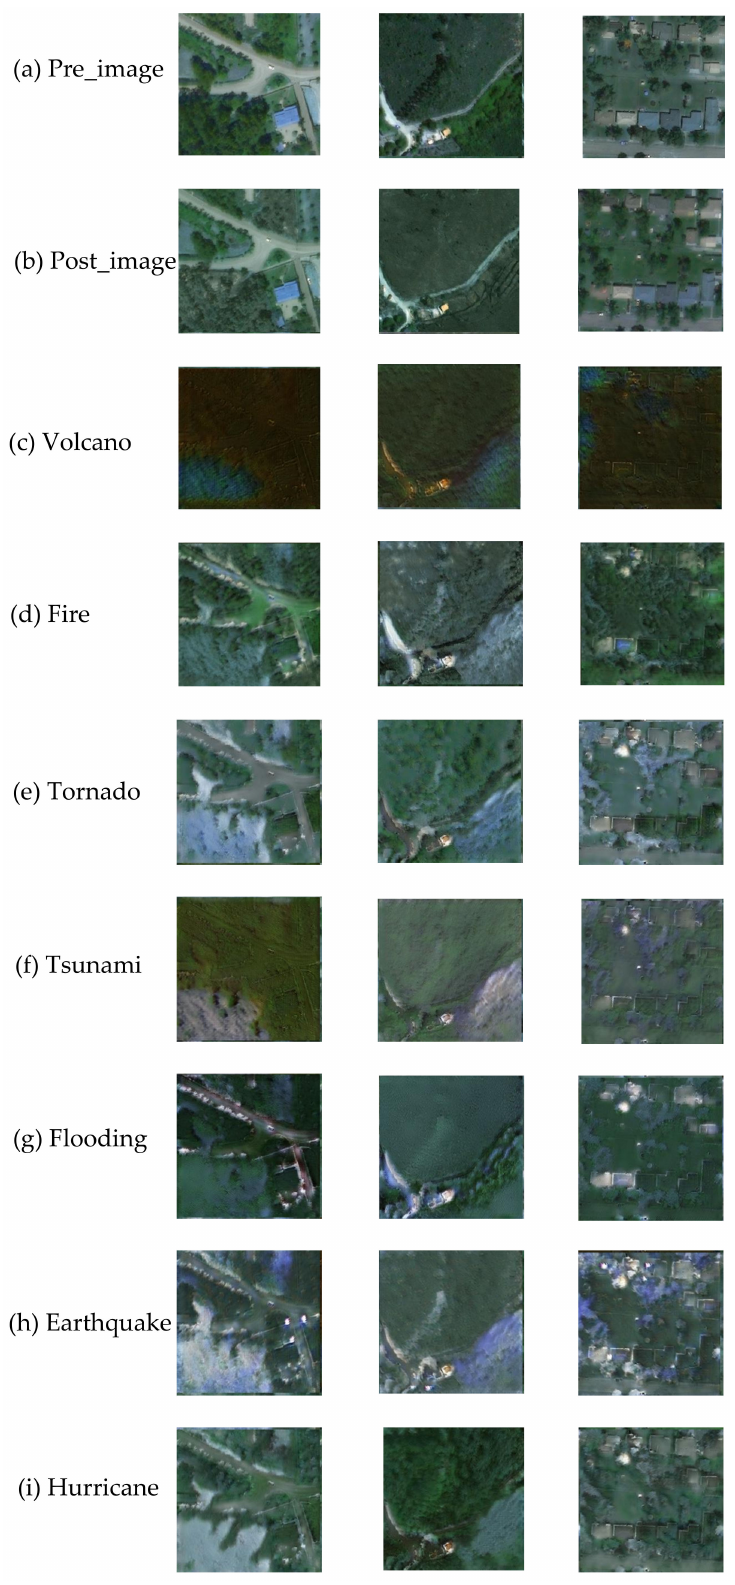
Figure 6. Multiple attributes-generated images results. ( a , b ) represent the real pre-disaster images and post-disaster images. The images ( c – i ) belong to generated images according to disaster types volcano, fire, tornado, tsunami, flooding, earthquake, and hurricane,